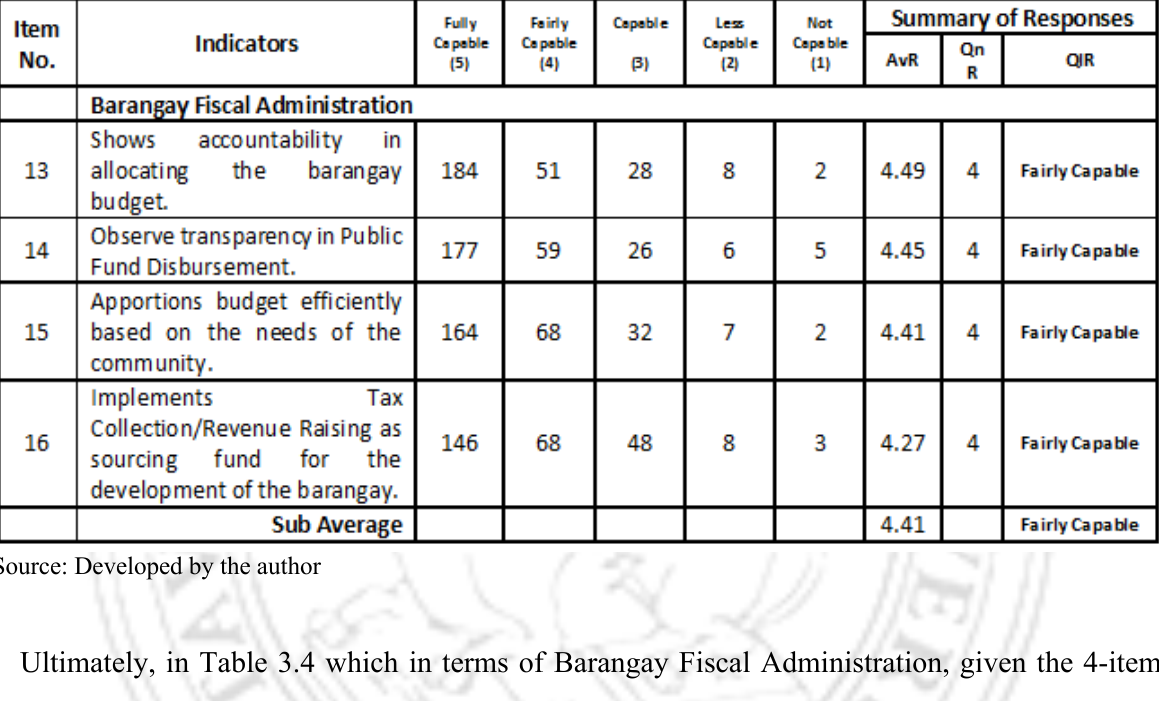
Table 3.4. The Perception of the Respondent-Barangay Officials in Northeast of Catanduanes regarding